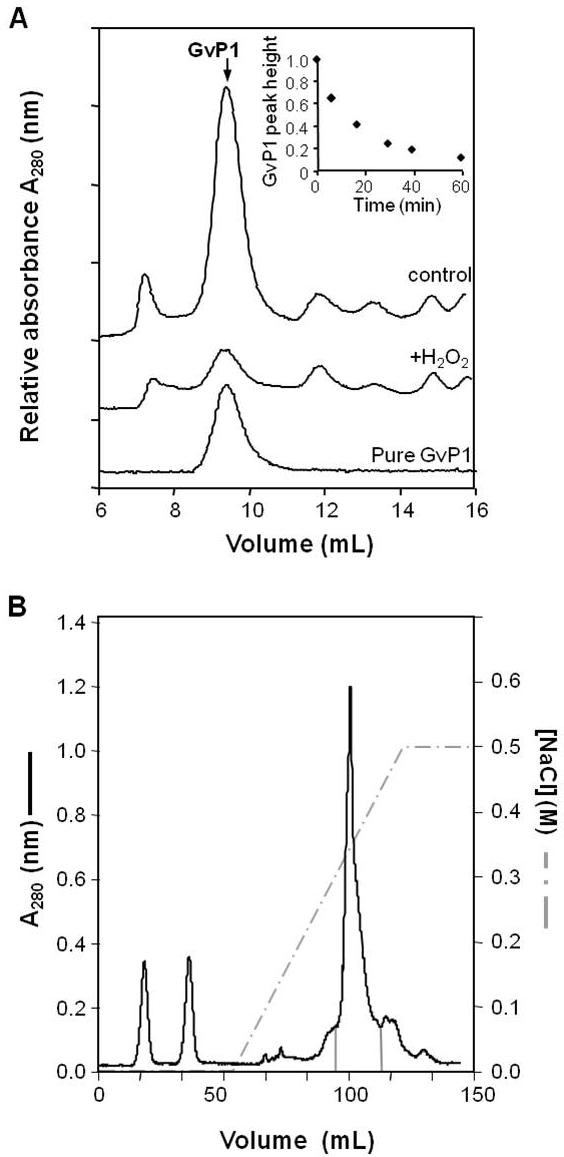
H2O2 causes insolubilisation of the grapevine extensin, GvP1. A) Superose-12 chromatography of EIBMPs (saline eluates of 35 mg (FW) cells) from untreated cells (trace control), cells incubated with 100 mM H2O2 (trace + H2O2). A chromatogram of pure GvP1 is also indicated as a reference. A time course assay of GvP1 insolubilisation in muro is depicted in the inset. B) SP-Sepharose chromatography of whole EIBMPs. Fractions enriched in GvP1 and subject to TCA fractionation for the purification of GvP1 are delimited by solid grey lines.